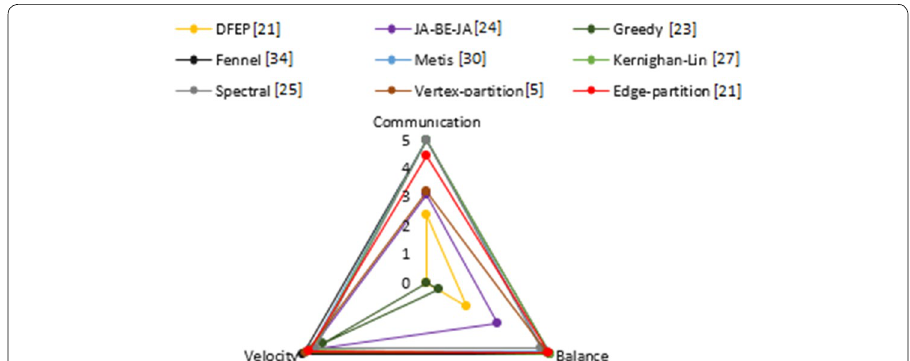
Fig. 13 Computational complexity of graph partitioning